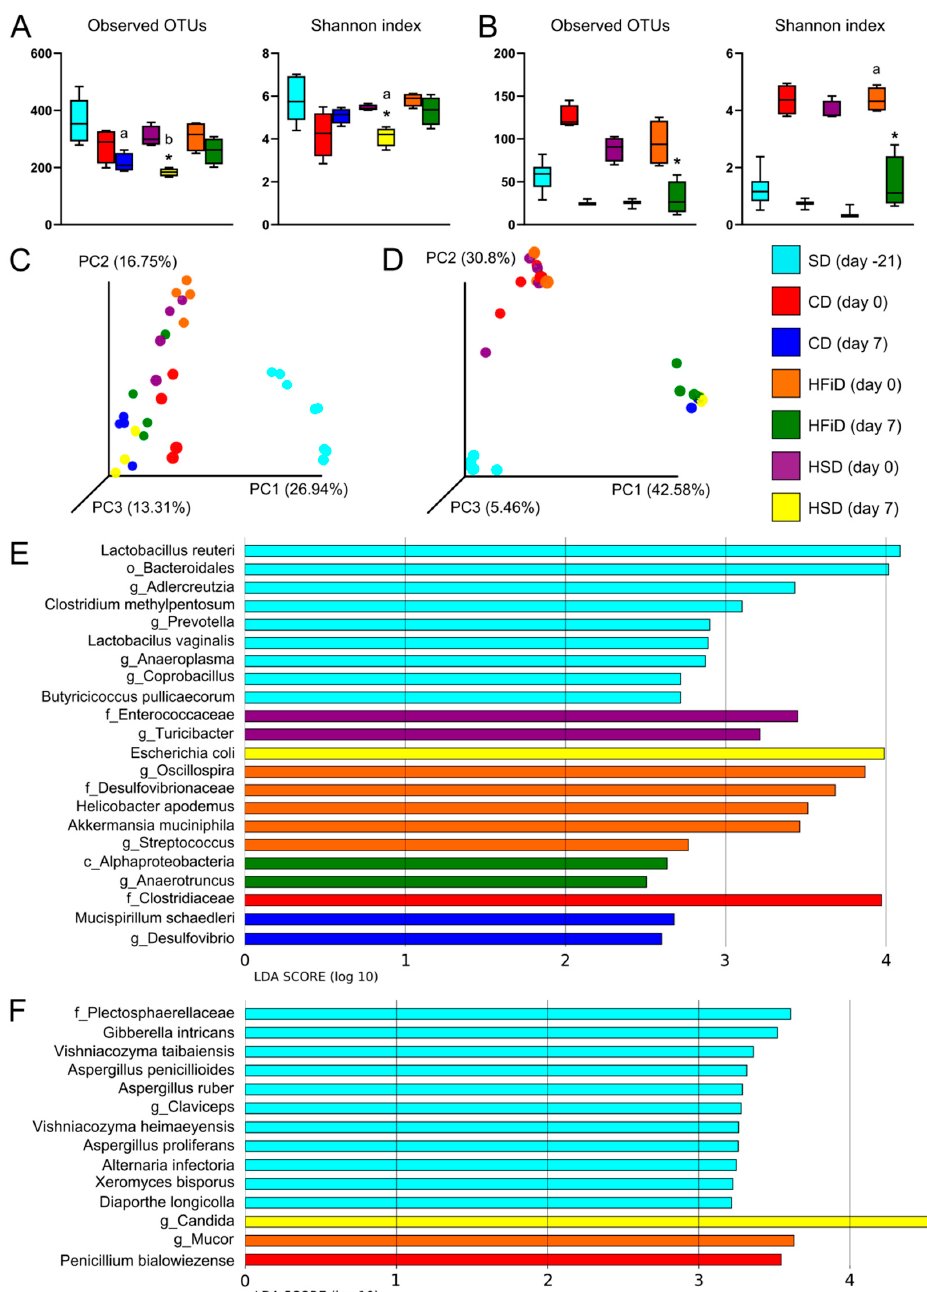
Figure 6. Diet and DSS treatment influence gut microbiota composition. Alpha diversity indices: observed operational taxonomic units (OTUs) and Shannon index for ( A ) bacteria and ( B ) fungi. The data are presented as box plots with determined mean and standard deviations (three or four mice per group). Means significantly different from day -21 (SD = standard diet) were calculated by ANOVA with p < 0.05 (a) and p < 0.01 (b), and means significantly different from respective day 0 (i.e., healthy mice vs. mice with colitis on day 7) were analyzed by t test * ( p < 0.05). Beta diversity results: Bray–Curtis principal co-ordinate analysis (PCoA) plots for ( C ) bacteria and ( D ) fungi and linear discriminant analysis effect size (LEfSe) analyses of significantly different strains of ( E ) bacteria and ( F ) fungi among groups. CD, control diet; HSD, diet rich in simple carbohydrates; HFiD, diet rich in fiber.